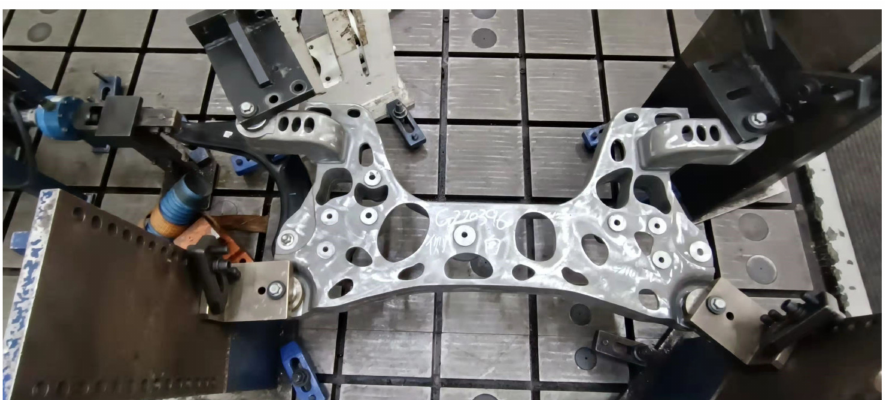
Figure 27. Lateral force fatigue endurance test of aluminium alloy front subframe on